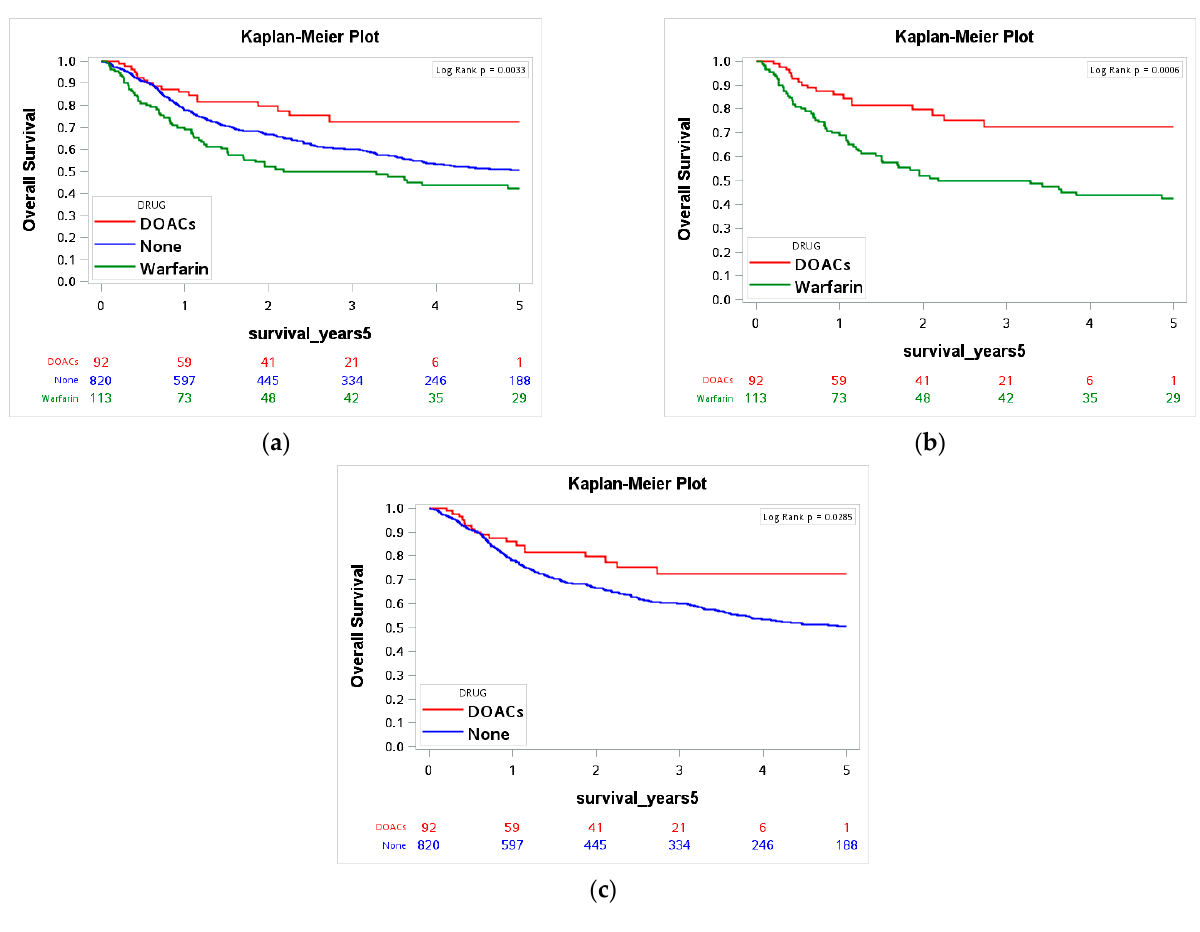
Figure 3. Kaplan–Meier survival curve of overall survival between ( a ) DOACs users ( n = 92), warfarin users ( n = 113) and non-users ( n = 820); ( b ) DOACs users and warfarin users; ( c ) DOACs users and non-users. Table 3. Overall survival between DOACs users, warfarin users and non-users. ( n =